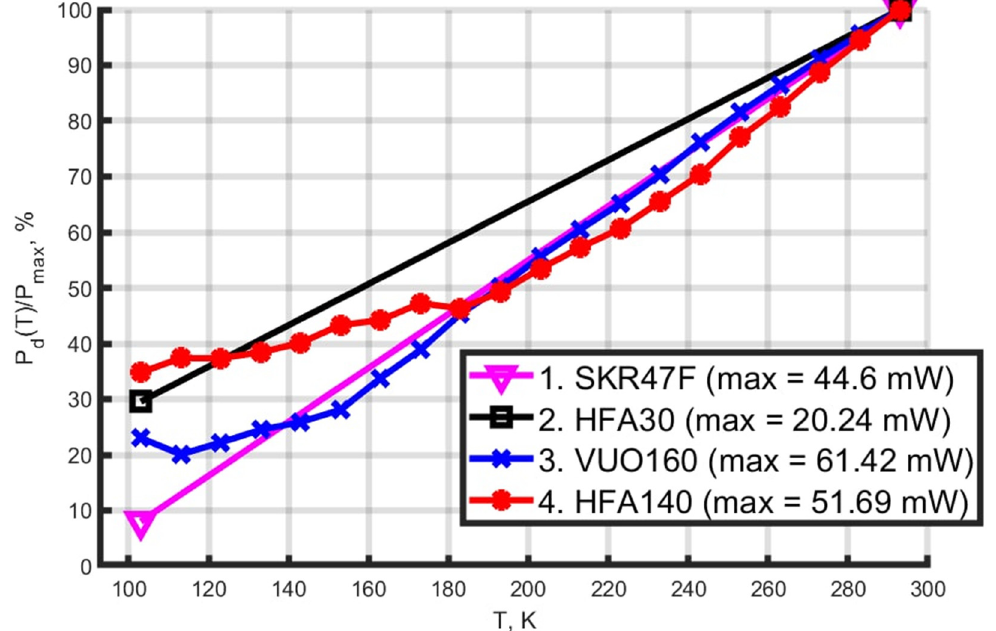
Figure 8. D ependencies of the normalized losses in the process of reverse recovery on temperature.